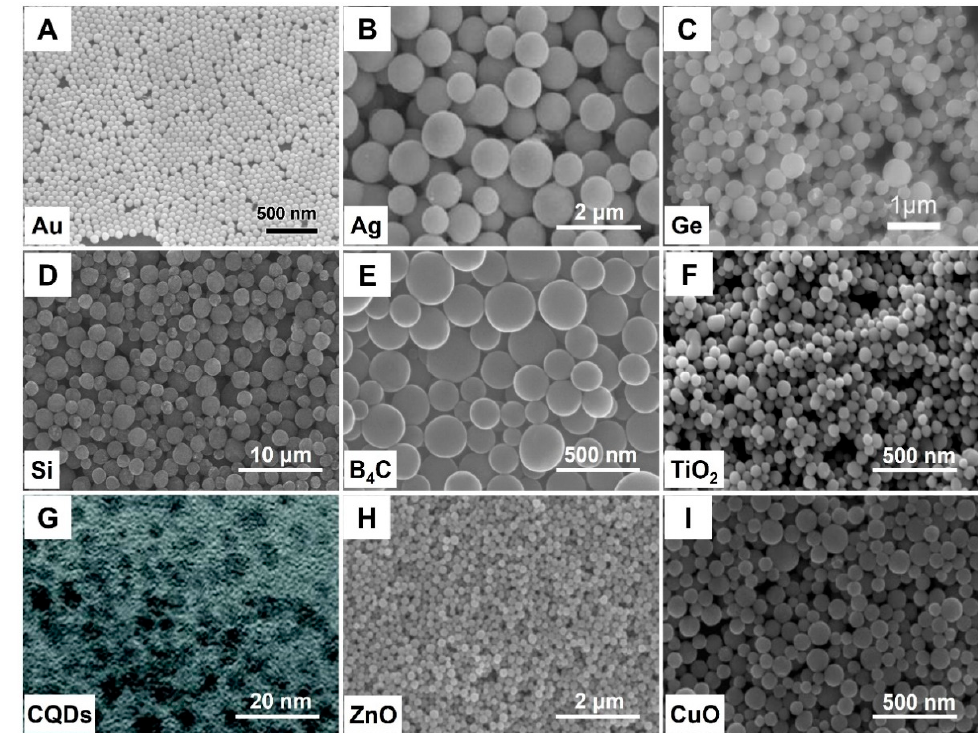
Figure 2. Preparation of colloidal nanospheres by pulsed laser heating in liquid medium. ( A ) Au. ( B ) Ag. ( C ) Ge. ( D ) Si. ( E ) B 4 C. ( F ) TiO 2 . ( G ) Carbon Quantum Dots (CQDs). ( H ) ZnO. ( I ) CuO. Reprinted with permission from Refs. [32–40].